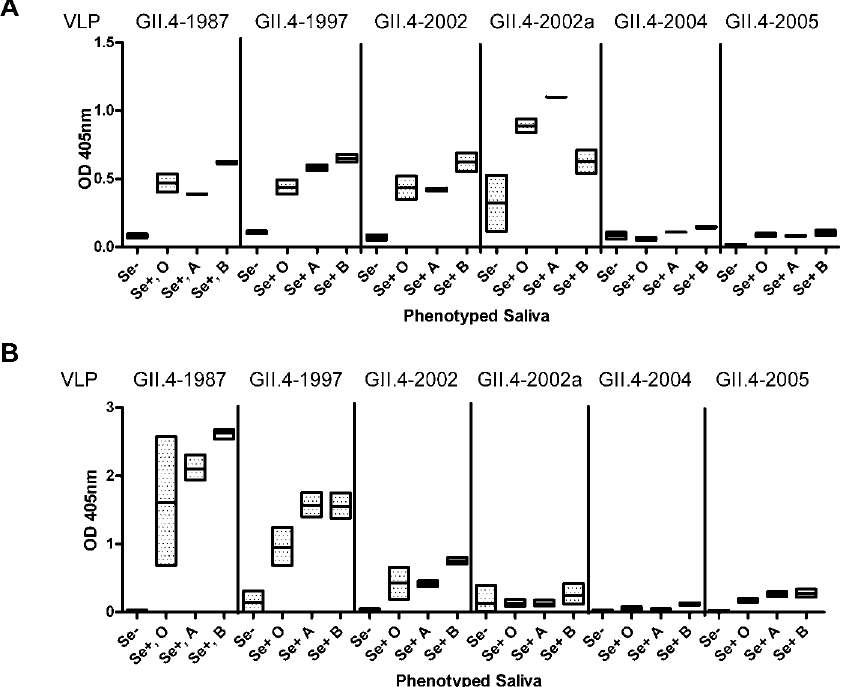
Figure 6. GII.4 VLP-Salivary Binding Patterns GII.4 VLPs were assayed for ability to bind to saliva samples phenotyped for secretor status (Se) and ABO blood type by ELISA. The mean optical density is indicated by the line in the box. The upper and lower boundaries of the box represent the maximum and minimum values. (A) VLP binding at 37 8 C. (B) VLP binding at room